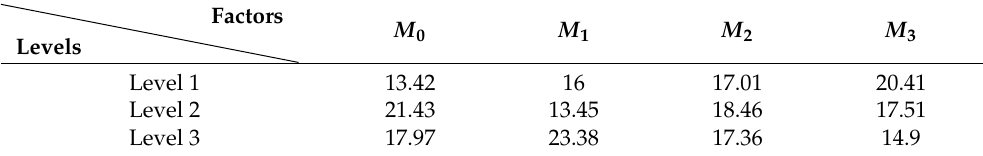
Table 5. Average Value of Different Factors on G T .